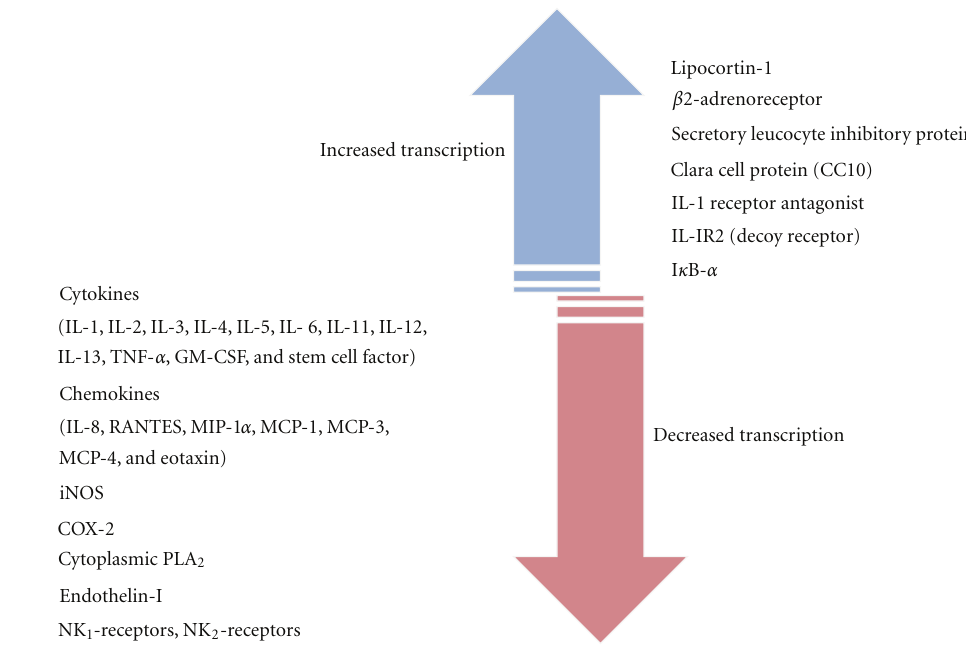
Figure 3: Action of glucocorticoids in gene transcription (adapted from